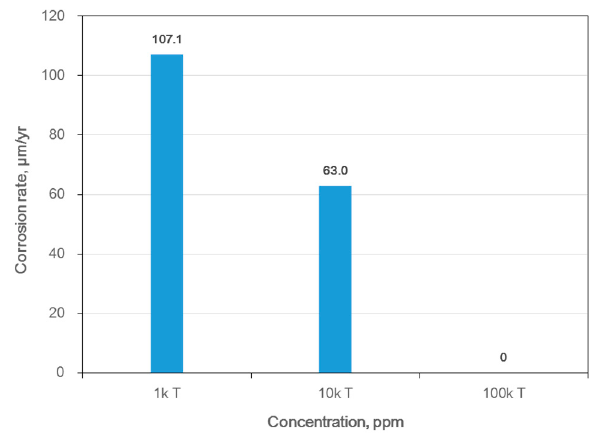
Figure 1. Effect of addition of a single corrosion inhibitor on the corrosion rate of ductile cast iron (DCI) in [tap water + x ppm tungstate (T)] at room temperature.